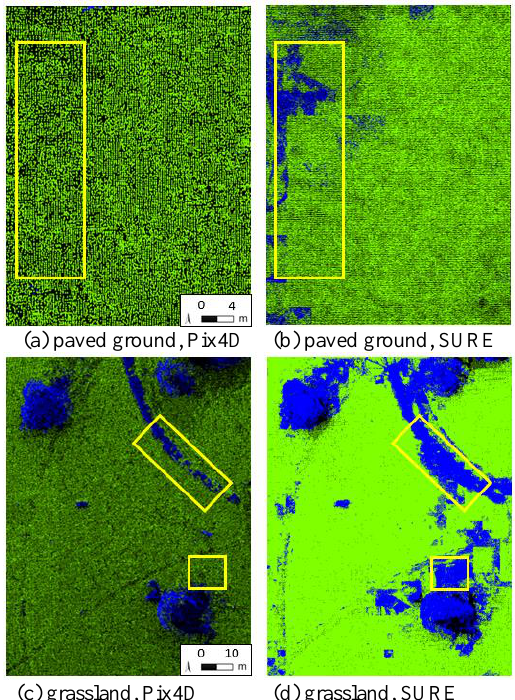
Figure 3. Filtering results on the paved ground and grassland. The green indicates the identified ground points; blue indicates non- ground points; black indicates data gaps. In (c) and (d), blue indicates identified non-ground points not only on the grassland, but also on the trees and bushes (cf. Fig. 2). Generally, the Pix4D point clouds in Fig. 3(a) and (c) are darker than SURE point clouds in Fig. 3(b) and (d) due to a lower point